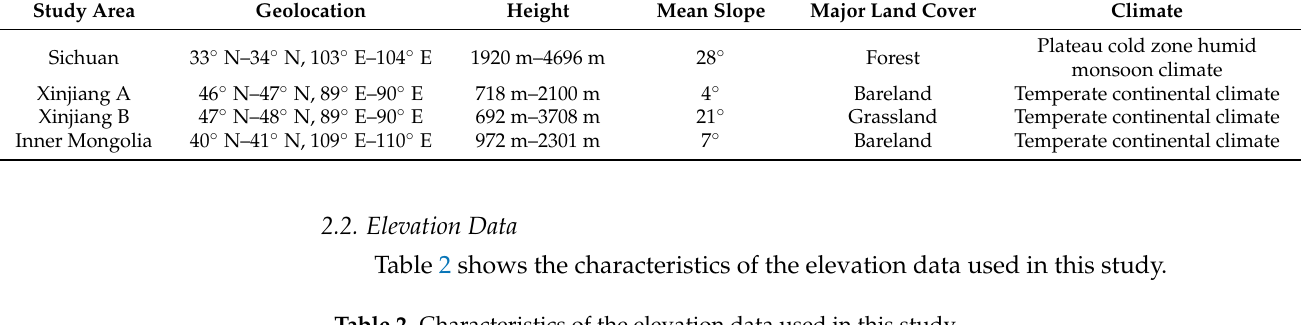
Table 2. Characteristics of the elevation data used in this